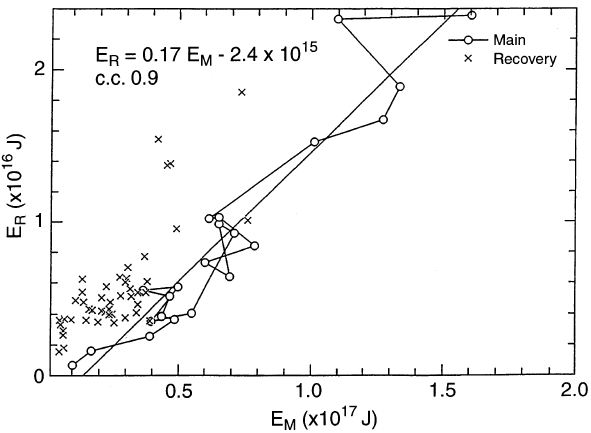
Fig. 6. Correlation between E R and E M for the intense magnetic storm of March 13–14, 1989 in the same format as in Fig. 5. The fitting line for the main phase is obtained by the least squares method. Time tracing lines similar to those in Fig. 4 are drawn for the main phase